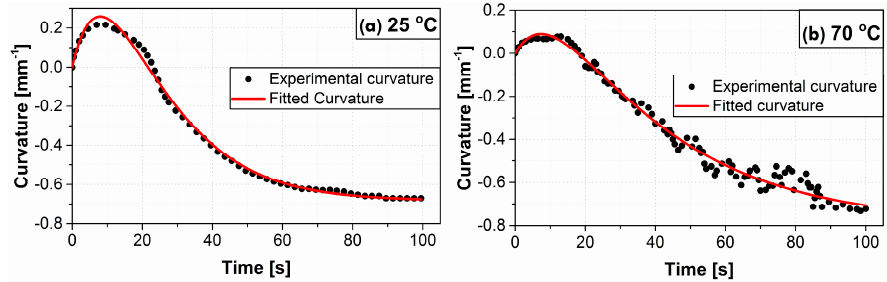
Figure 6. Experimental and fitted time dependent curvature at ( a ) at 25 °C, and ( b ) 70 °C.